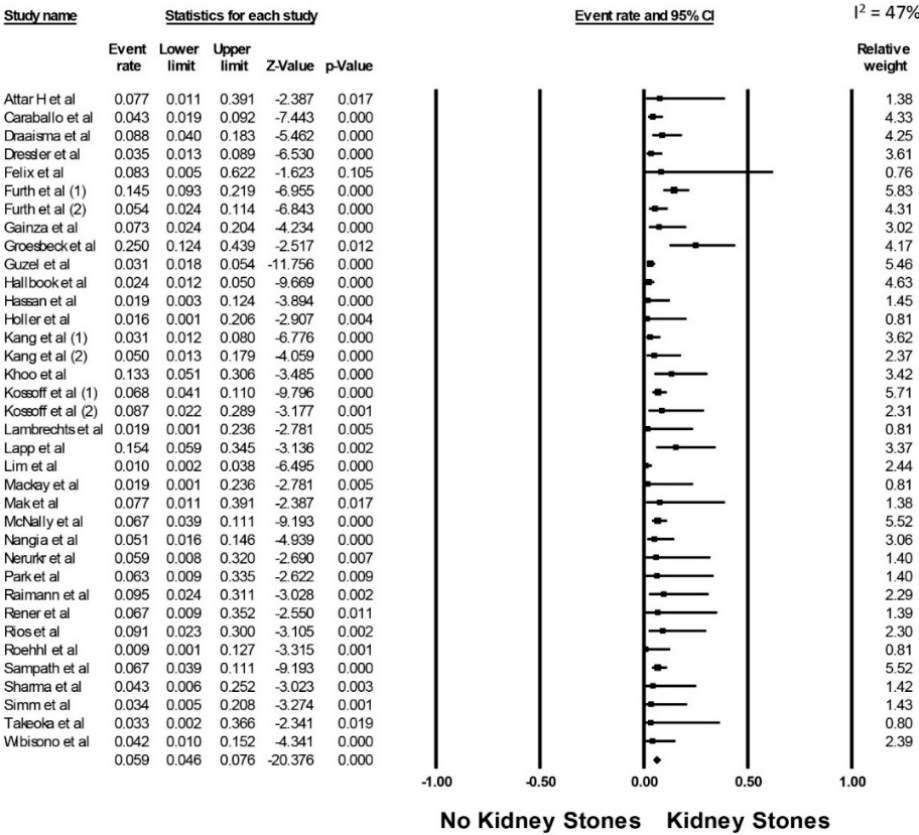
Figure 2. Pooled estimated incidence of kidney stones.